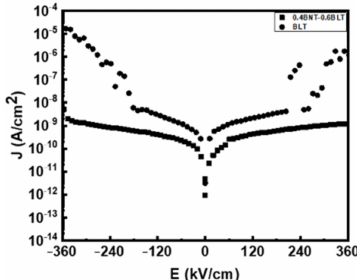
Figure 5. Leakage current density vs. electric field (JE) curves of BLT and 0.4BNT0.6BLT films.